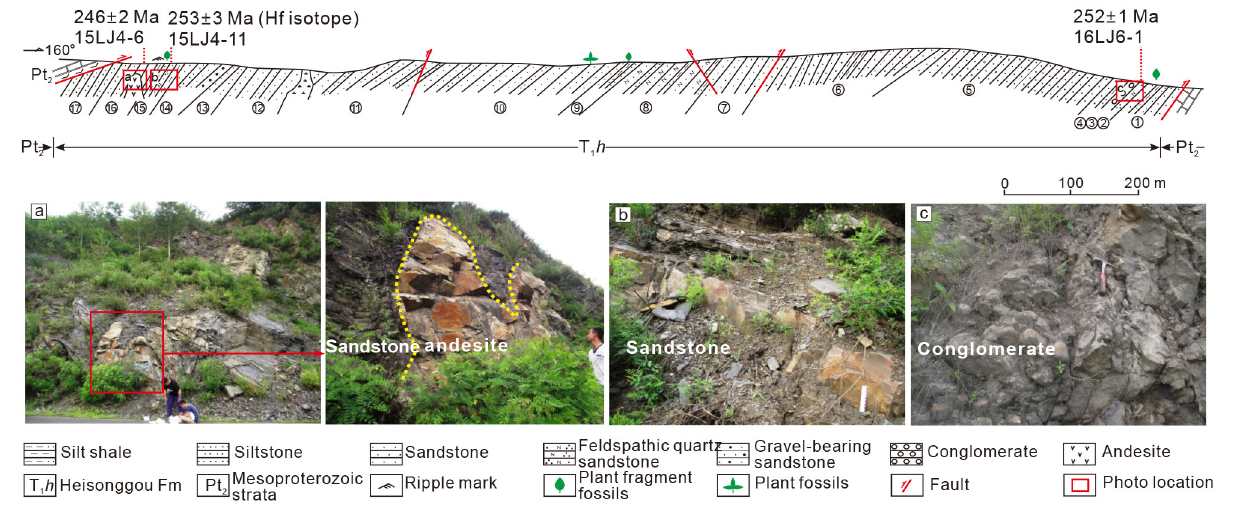
Figure 4. Stratotype outcrop of the Heisonggou Formation and sampling locations. The location of the stratotype is indicated by the dotted line in Fig. 2 (Sect. 3). The numbers in circles show the sequence of beds in the section. The ages refer to the youngest zircon age populations of samples.